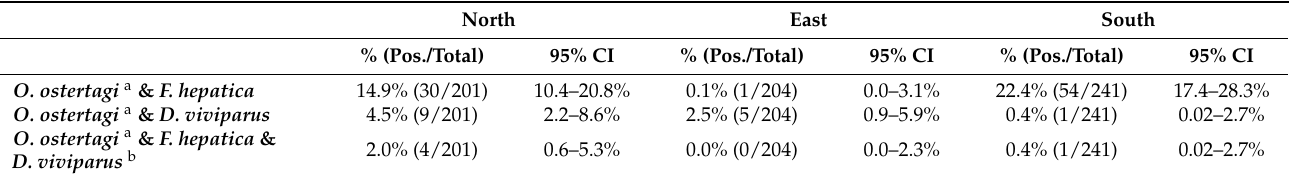
Table 2. Patterns of parasite co-exposure in 646 BTM samples from three different regions of Germany. North